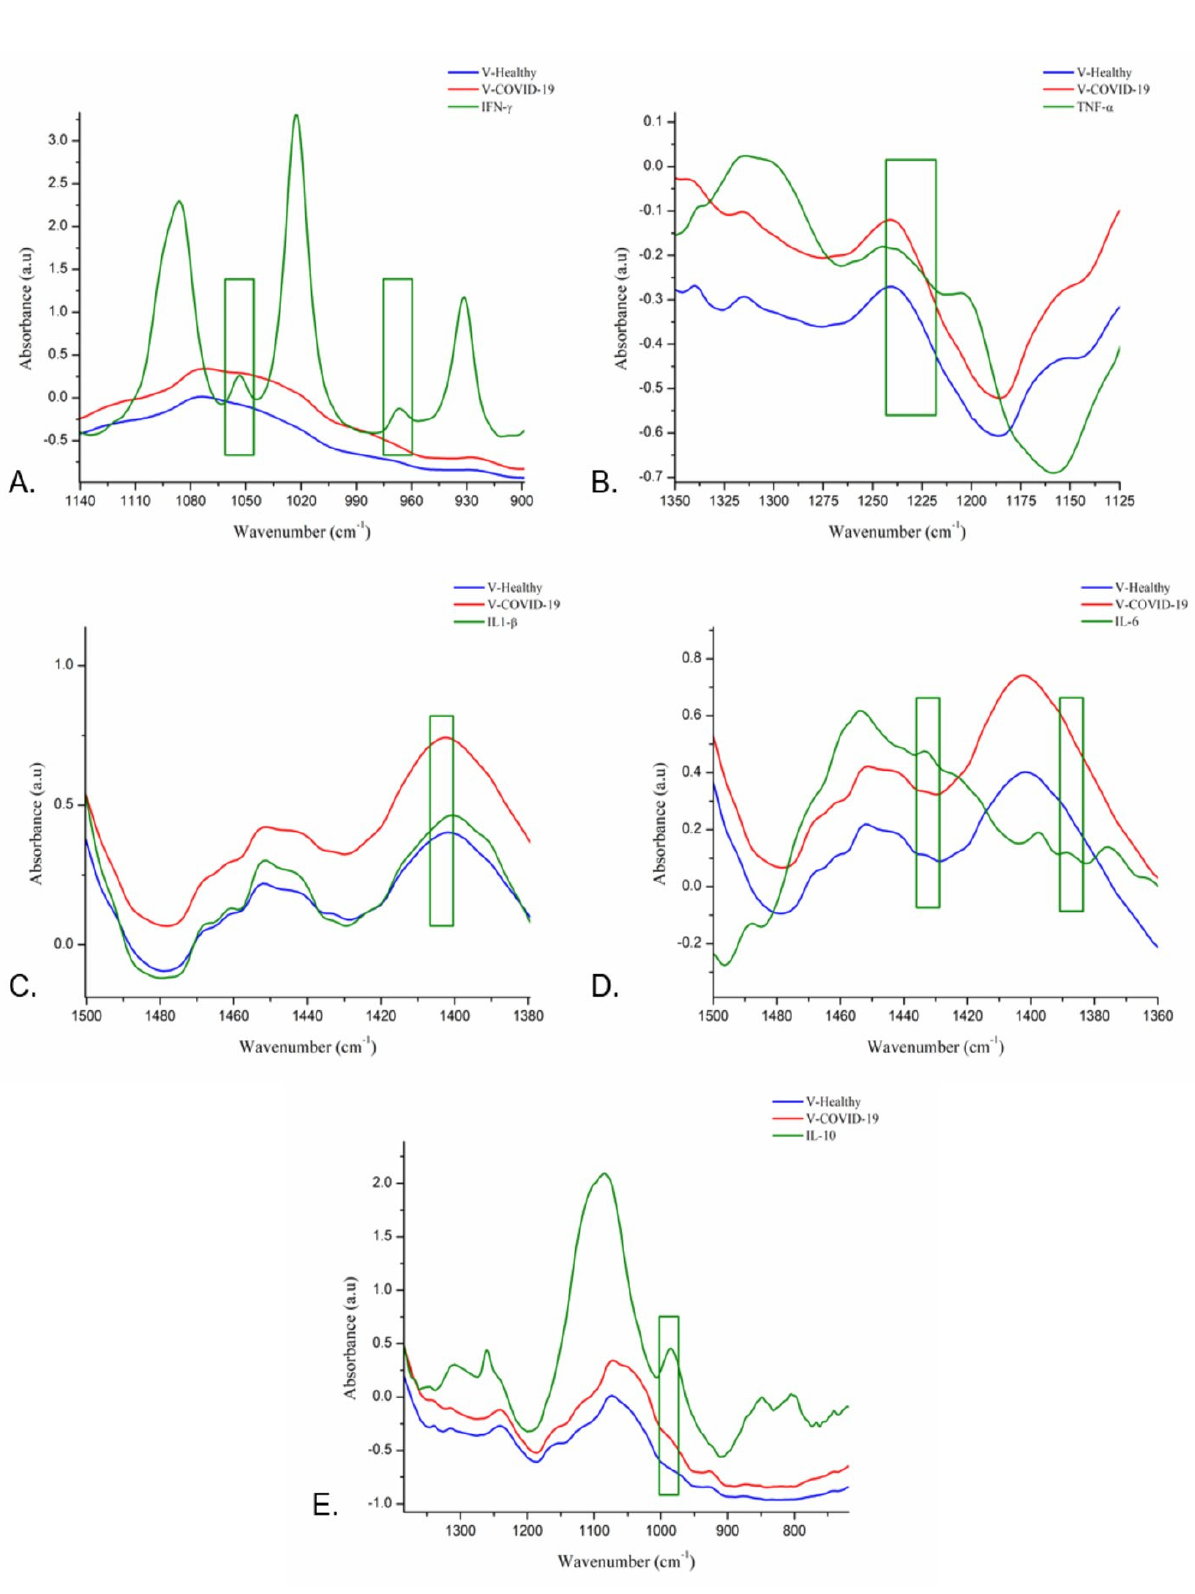
Figure 4. Cytokine analyses through FTIR. The regions at 978–956 cm − 1 and 1061–1044 cm − 1 are associated with IFN- γ ( A ), the regions at 1243–1217 cm − 1 and 1409–1399 cm − 1 are related to TNF- α ( B ) and IL-1 β ( C ), respectively, and the regions at 1393–1381 cm − 1 and 1436–1428 cm − 1 are linked to IL-6 ( D ) and IL-10 ( E ).